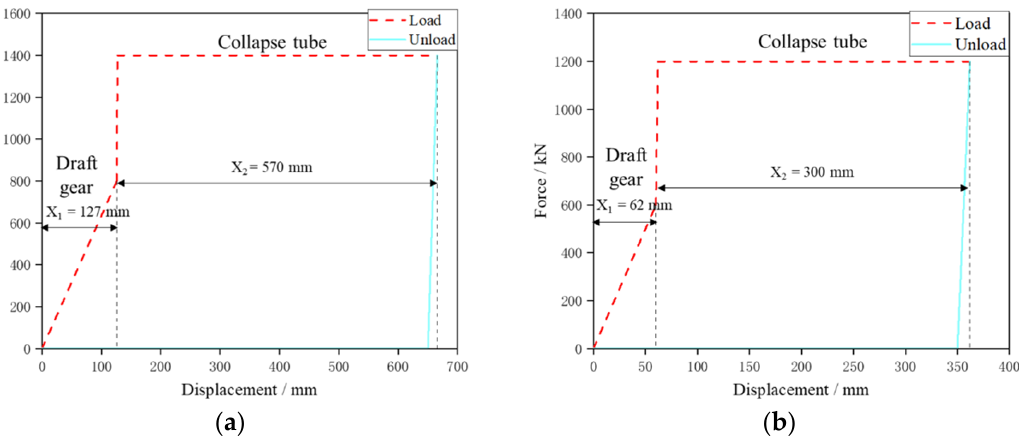
Figure 4. Coupler buffer device energy absorption characteristic curve: ( a ) the head car, ( b ) the middle car.